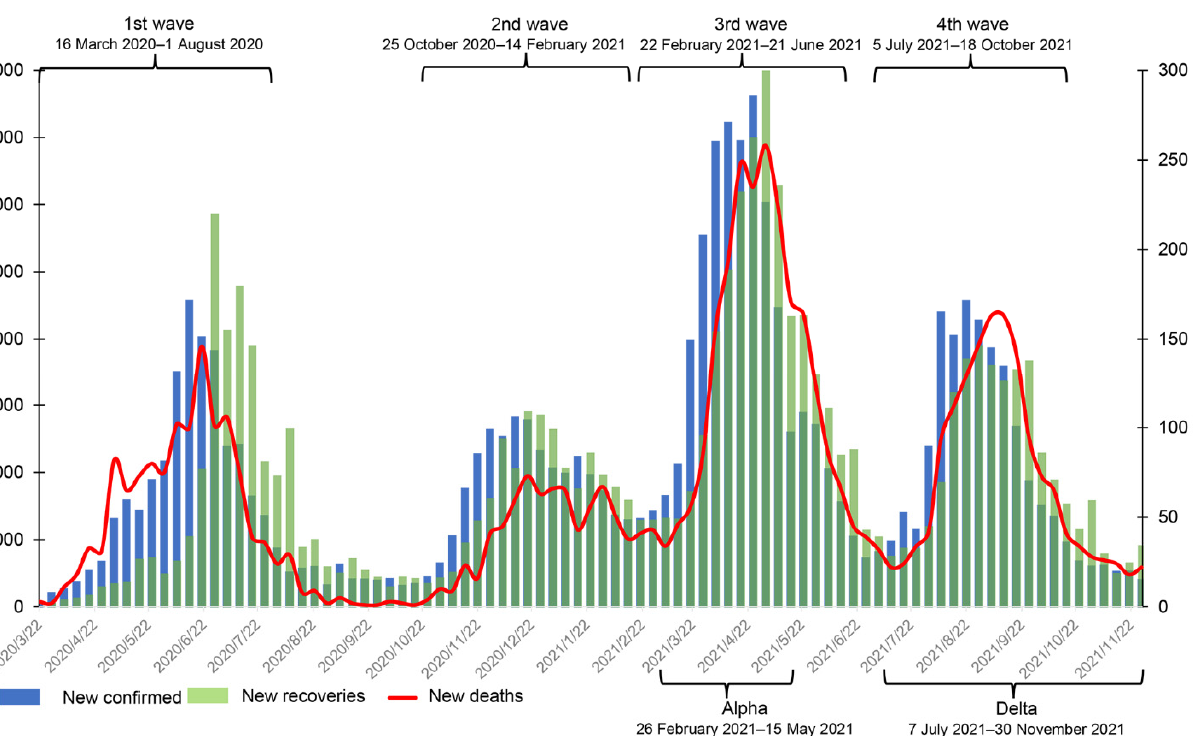
Figure 1. The weekly number of new confirmed cases, deaths, and recoveries from 16 March 2020 to 30 November 2021 in Khyber Pakhtunkhwa, Pakistan. The data were obtained from the official website of the Pakistan government (https://covid.gov.pk/stats/kpk (accessed on 16 August 2022)).